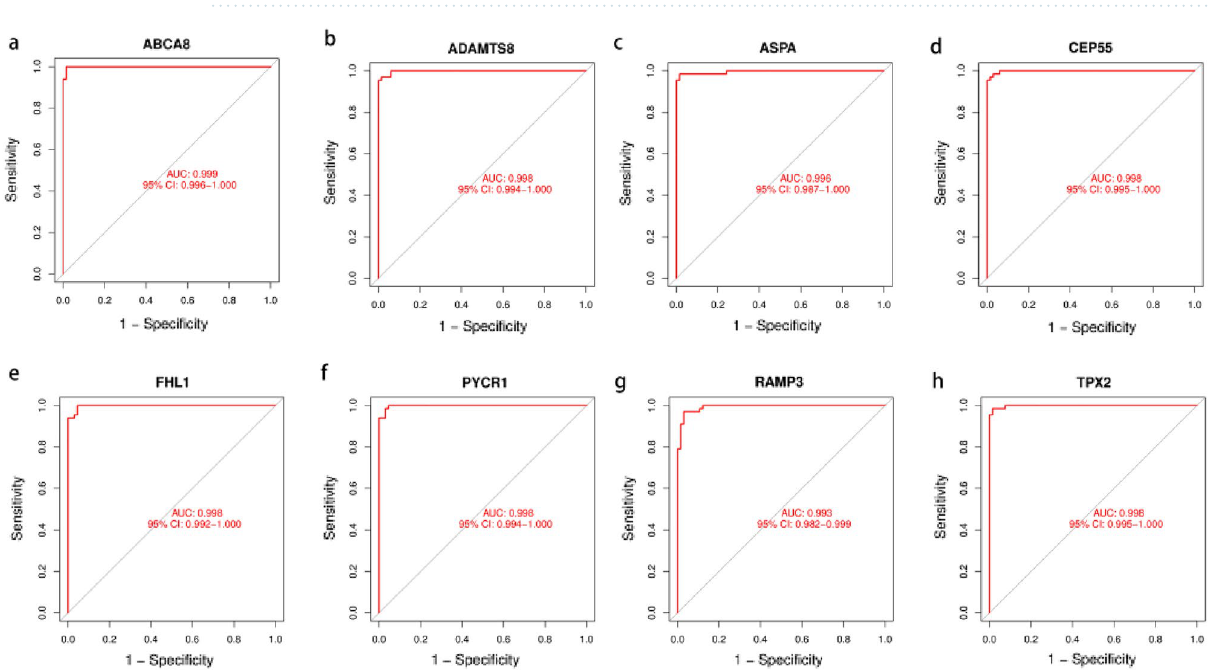
Figure 6. ROC curves for eight biomarkers in the training dataset(GSE18842 and GSE21933). ( a ) ABCA8. ( b ) ADAMTS8. ( c ) ASPA. ( d ) CEP55. ( e ) FHL1. ( f ) PYCR1. ( g ) RAMP3. ( h )